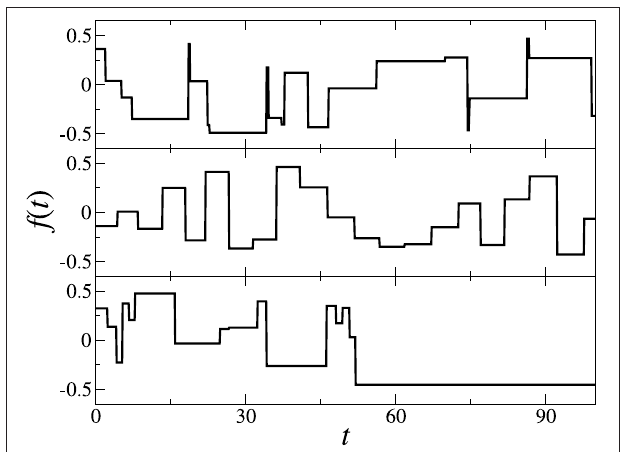
FIGURE 2 | Time trace of the telegraphic noise f ( t ) generated in simulation. From Top to Bottom the sample noise was generated from the duration time e − τ/τ c , gaussian P ( τ ) PDFs: poissonian P ( τ ) ∝ τ − (1 + α ) . The parameters we used are τ c power-lawed P ( τ ) ∝ α 1.2, and the unit time step 0.01, which gives the theoretical values for = T →∞ d ττ P ( τ )) 5 (poissonian, gaussian) and 6 (power-law). The [ τ ] T ( 0 = ≡ →∞ noise strength f i was chosen from a uniform distribution in the interval of R [ 0.5,0.5]. −